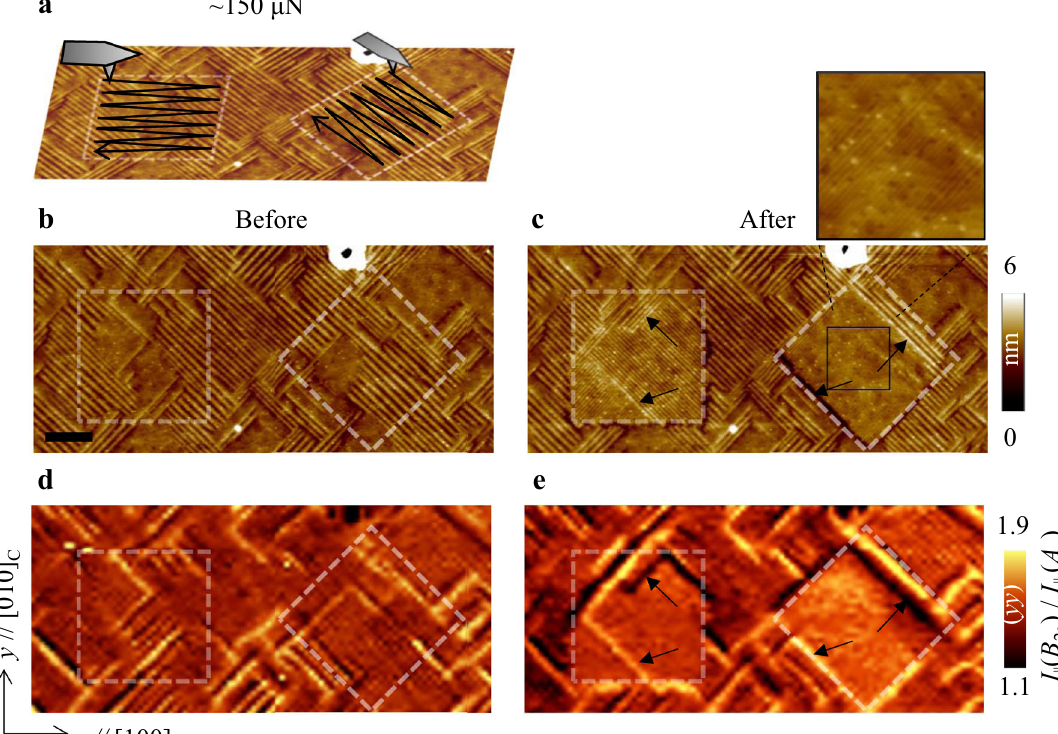
Fig. 7 Mechanical writing of JT domains by AFM tip. a Area scans by a tip imposed by a normal force of ~150 μ N. The black lines indicate the fast scan direction of a tip along 0° and − 45° with respect to [100] C . AFM images of the LMO fi lm before ( b ) and after ( c ) the mechanical writing. The black boxed image is a zoomed-in image of the region marked in c . Raman maps of the B 2g mode before ( d ) and after ( e ) the writing over the same region. Transparent dashed boxes indicate the scanned regions. The black arrows indicate representative lines where the bundles of the W-wall-type domains collide other orthogonal bundles. Scale bar represents 1 μ